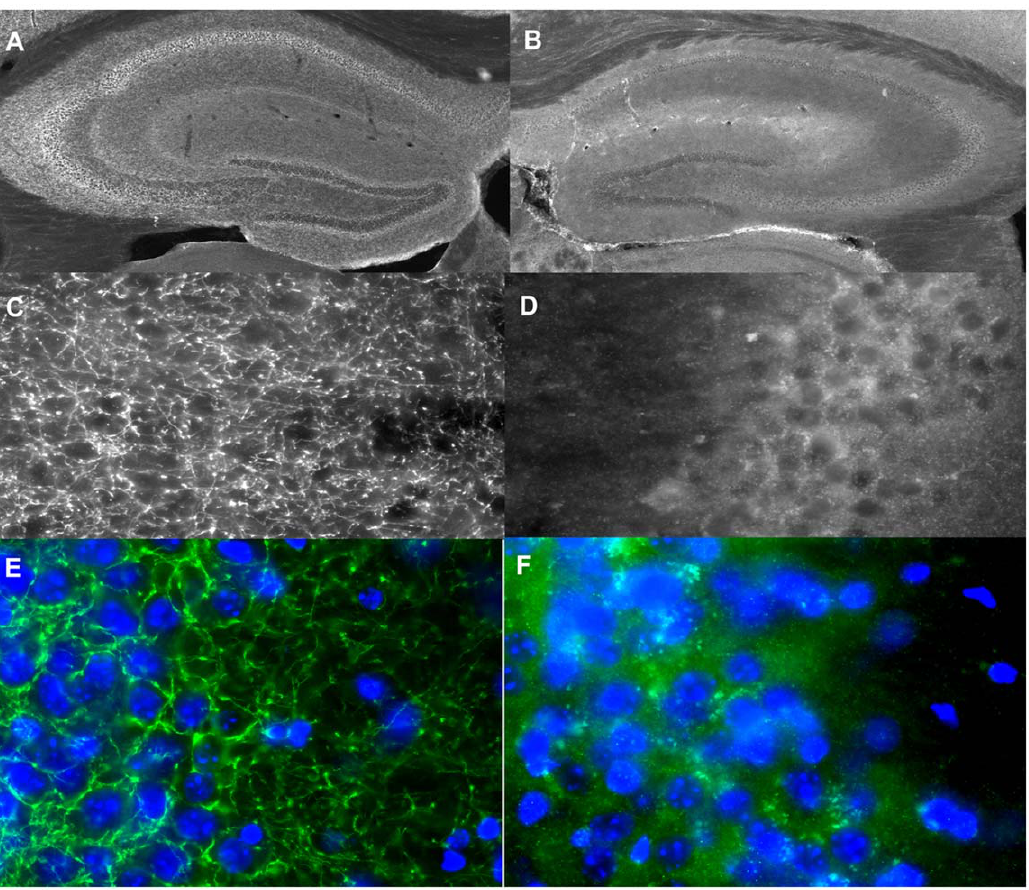
Figure 4. CB 1 receptor immunoreactivity in the hippocampal formation. Representative low-magnification (4 x) showing CB1-IR throughout the hippocampus of WT (A) and IR-hCB1 -/- (B) mice. Higher-magnification (20 x) of the CG3 displays a dense network of CB1 immunoreactive fibers in WT mice (C) almost undetectable in IR-hCB1 -/- animals (D). Enlarged images (60x), of CG3 area showing CB1R staining (green) in throughout the neuronal processes from WT (E) and transgenic mice (F). Nuclear staining of DNA with DAPI (blue) revealed that, contrary to the WT, in IR-hCB1 -/- the CB1-IR diffuses into cytoplasm and almost lacks in neuronal membranes and fibers.